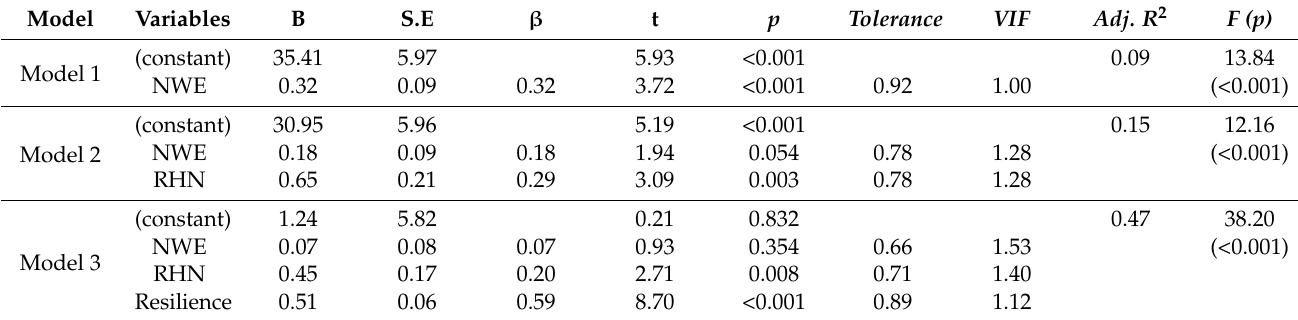
Table 5. Hierarchical regression analysis of predictors associated with posttraumatic growth ( n = 127).